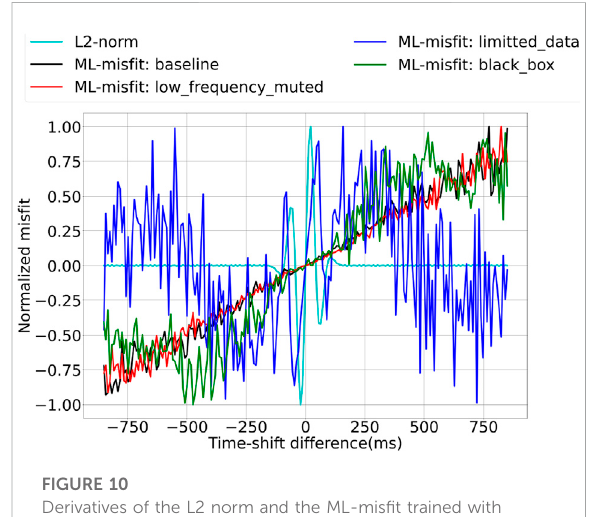
FIGURE 10 Derivatives of the L2 norm and the ML-mis fi t trained with different setups. The main frequency is 10